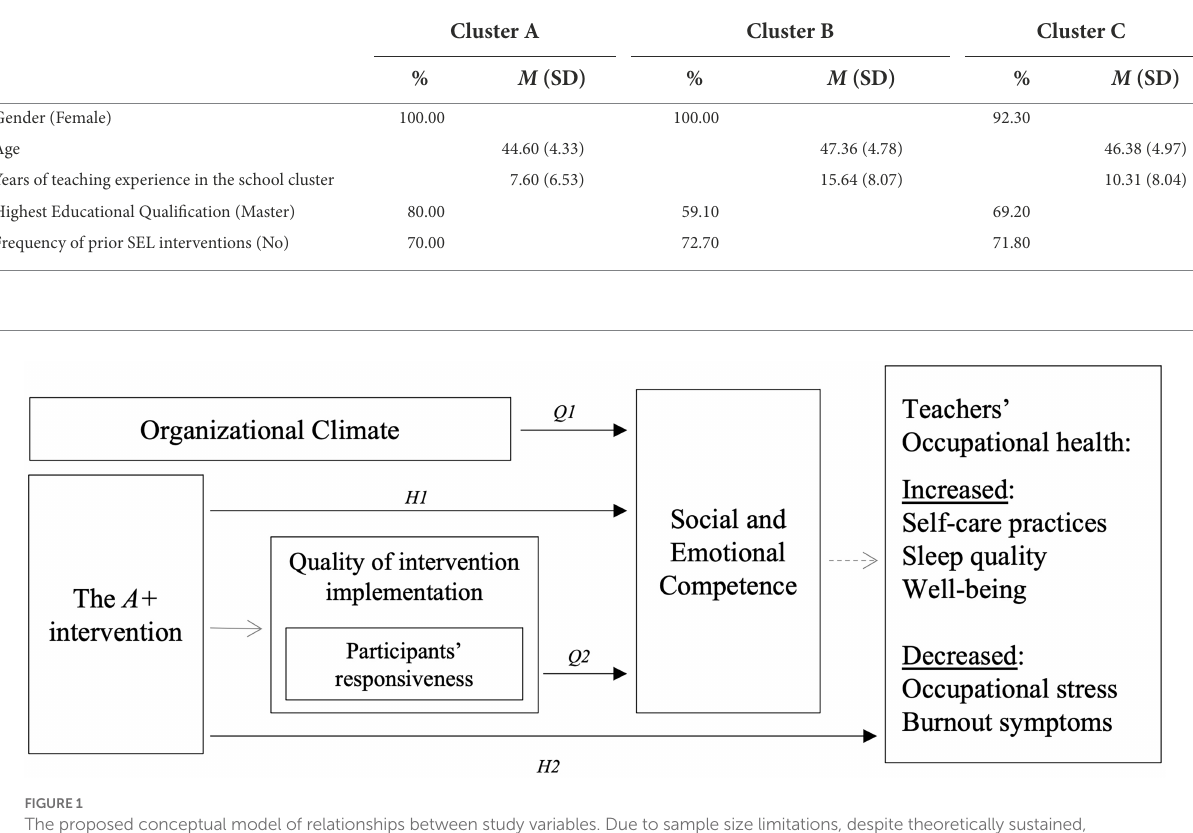
TABLE 1 Participants’ sociodemographic characteristics between school clusters (percentage of the most frequent category, mean and standard deviation).